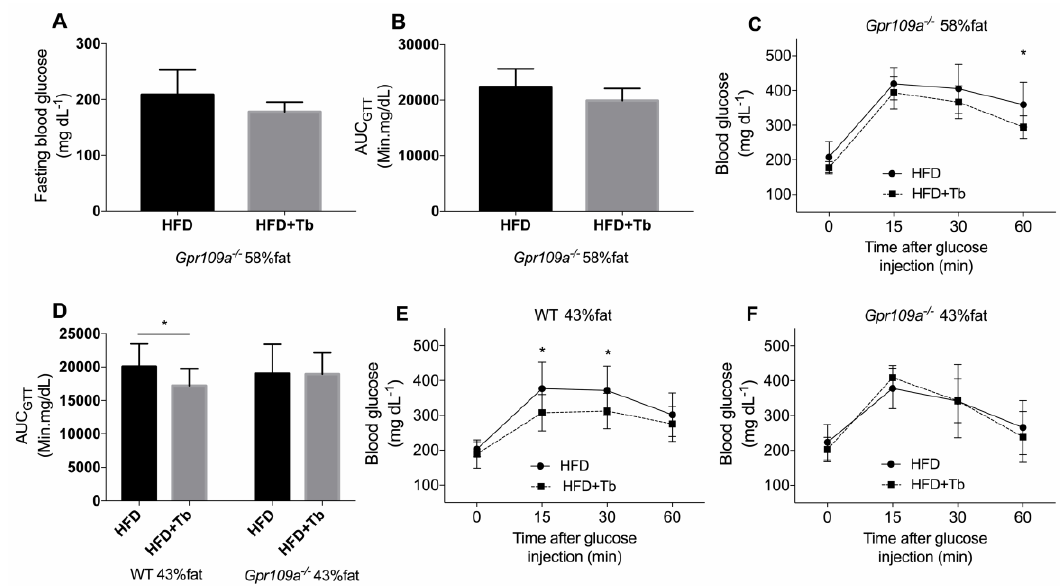
Figure 6. Tb improved glucose homeostasis in obese mice through a GPR109A-dependent mechanism. ( A ) Glucose quantification in samples from 6 h fasted Gpr109a − / − mice ( n = 8, 9 mice per group). ( B ) Incremental area of blood glucose (GTT) at the 12th week of the protocol in Gpr109a − / − mice ( n = 8, 9 mice per group). ( C ) GTT curves for Gpr109a − / − mice are presented ( n = 8,9 mice per group). ( D ) Incremental area of blood glucose (GTT) at the 12th week of the protocol in WT and Gpr109a − / − mice ( n = 9–14 mice per group). ( E ) GTT curves of WT mice are presented ( n = 12–14 mice per group). ( F ) GTT curves of Gpr109a − / − mice are presented ( n = 9 mice per group). For this experiment, GTT was performed with the use of 1 g / kg glucose and a blood glucose meter (Accu-Check Performa ® ). Data are presented as mean ± SD (n is presented for each result). * p < 0.05 HFD vs. HFD + Tb. Student’s t- test.